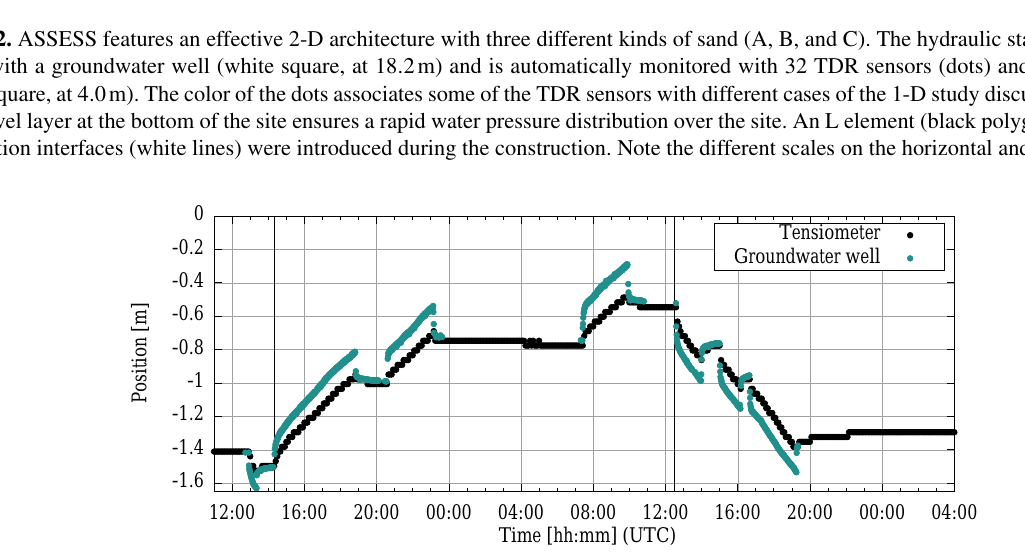
Figure 3. The position of the groundwater table was measured manually in the groundwater well and automatically with the tensiometer (Fig. 2) during three different phases (initial drainage, multistep imbibition, and multistep drainage – separated by the vertical black lines in the figure) of the experiment. Note that the discrete measurement steps reflect the resolution of the